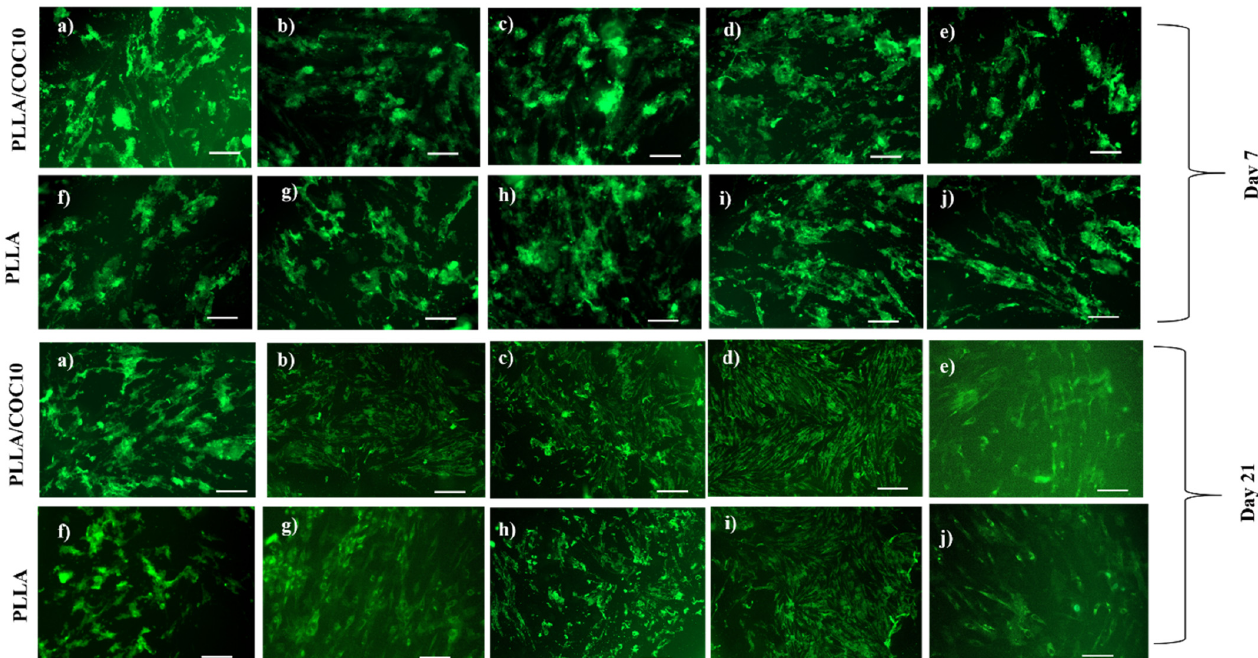
Figure 9. LIVE/DEAD assay BMSC grown on PLLA/COC10-nHA and PLLA/nHA at various times were tested. The scale bar is 1 µ m in all the images. Nanocomposites had nHA in 1 wt%, 5 wt%, 10 wt%, and 20 wt%. PLLA/COC10-nHA on day 1 ( a – j ) represented cell adhesion better than PLLA/nHA. Day 14 ( a – j ) cells were proliferating, whereas multilayer cells were proliferating at an accelerated rate on day 21 ( a – j ).